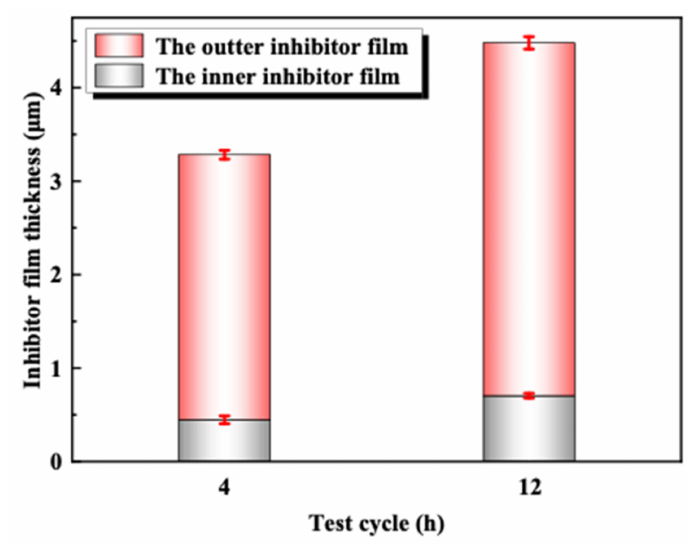
Figure 10. Thickness measurement results of corrosion inhibitor film at different test cycles.